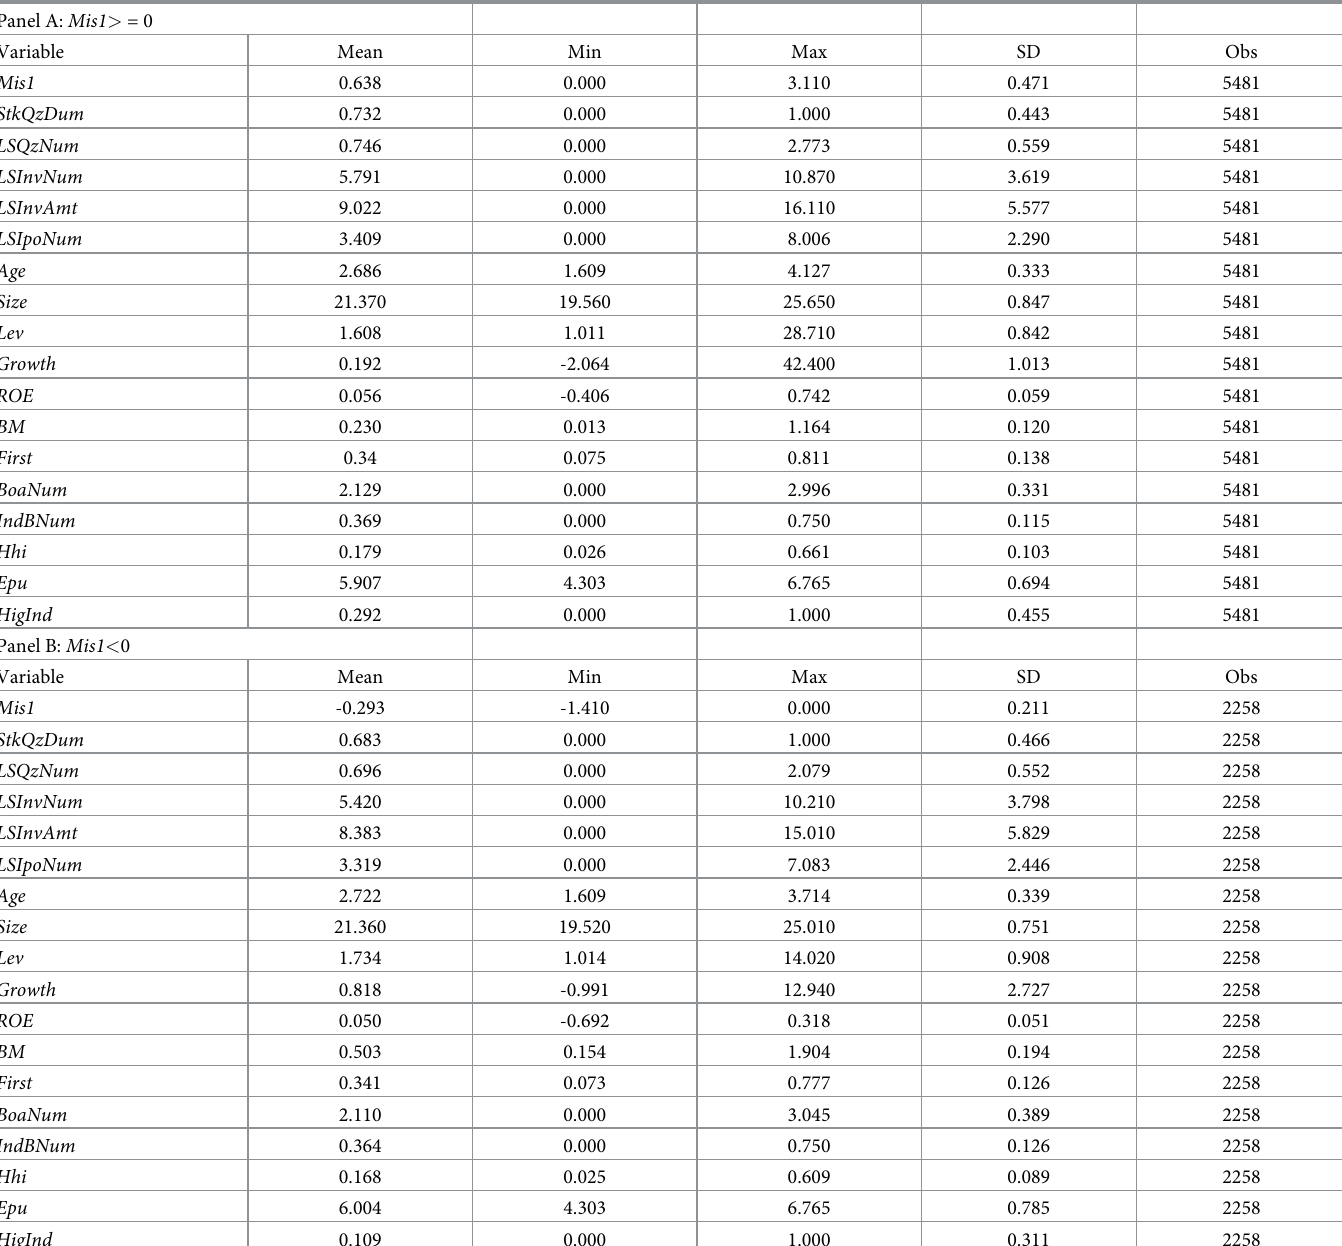
Table 1. Descriptive statistics. This table reports descriptive statistics for all dependent and independent variables used in the